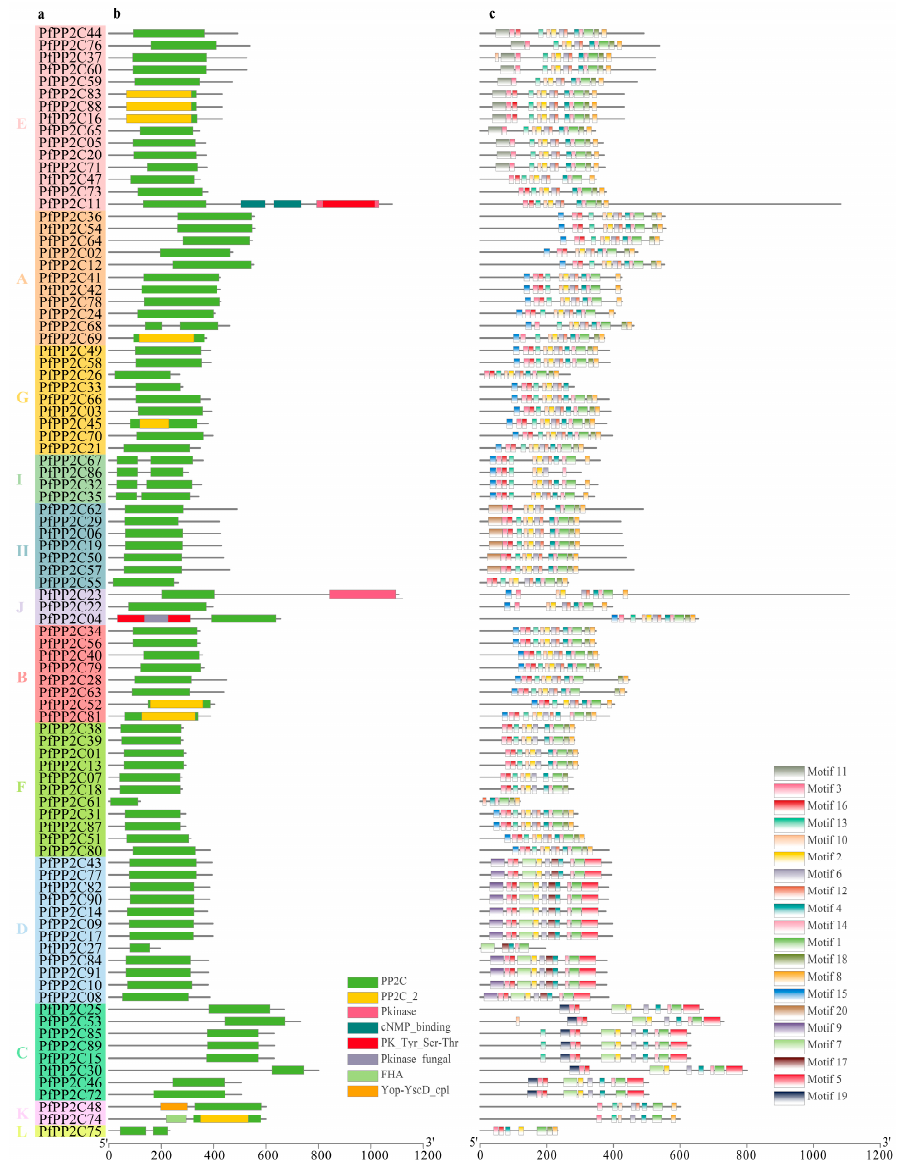
Figure 4. Subfamily grouping (a), conserved structural domain analysis (b) and conserved motif analysis (c) of PP2C gene family of P. fortunei. Table 2. Conserved motif information of the PP2C gene family in P. fortunei.